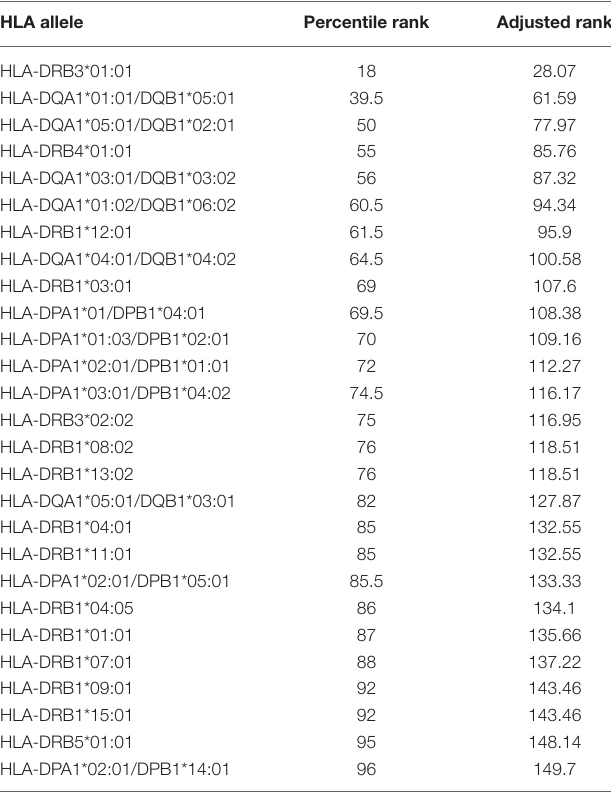
TABLE 4 | MHC-II binding prediction for HLA allele frequencies and reference sets with maximal population coverage for the conserved amino acid sequence R1 among Salmonella OmpC